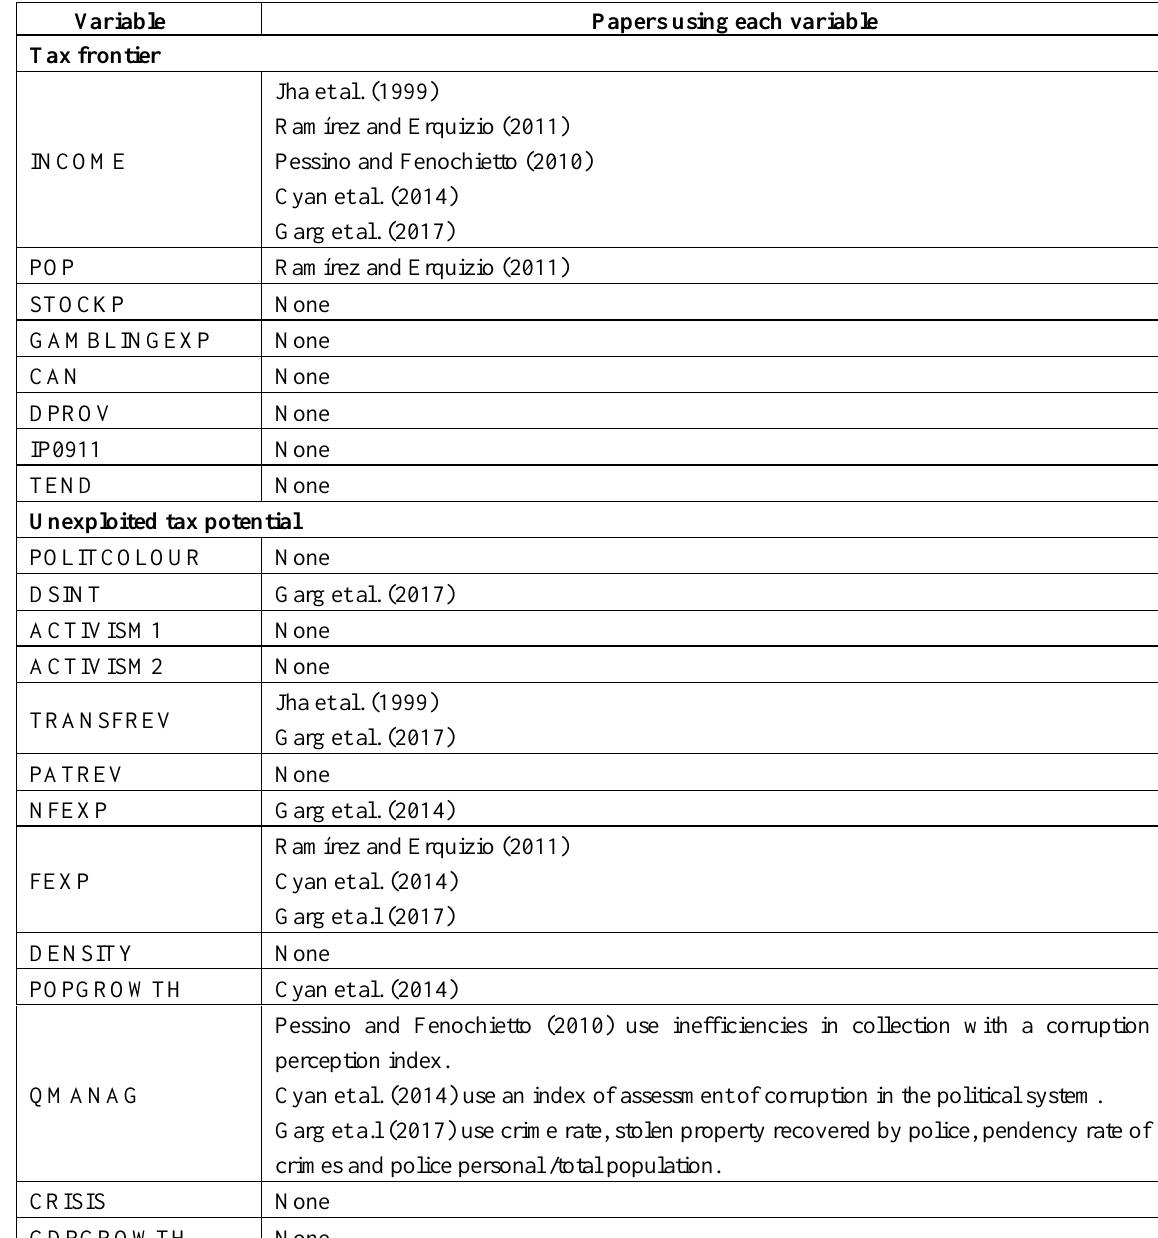
Table A.4 : Explanatory variables used in the SFA